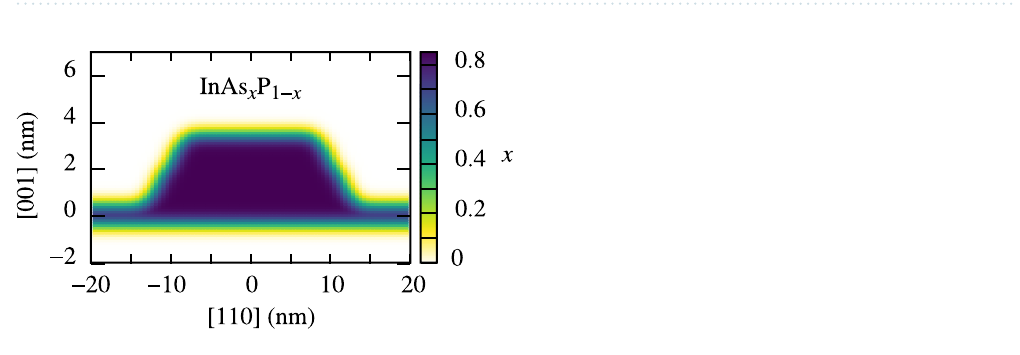
Figure 2. A Cross-section of an exemplary InAs/InP QD material composition. Color indicates the local x value, i.e., As